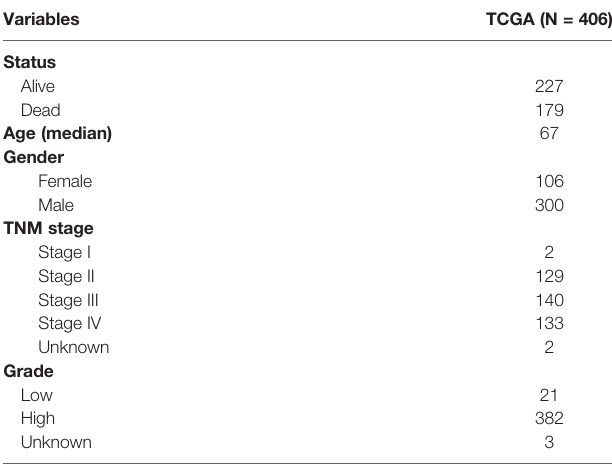
TABLE 1 | Clinical characteristics of patients in TCGA